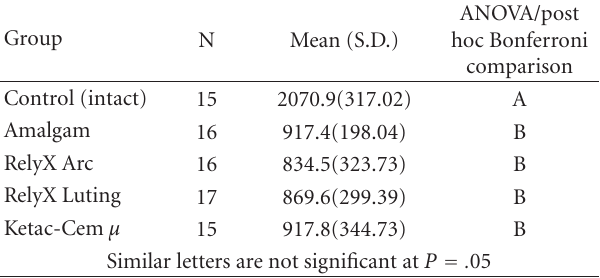
Table 1: Mean fracture strengths and standard deviations of tested